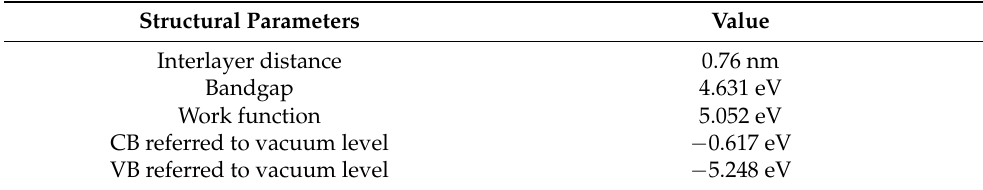
Table 2. Structural parameters of MgAl-LDH